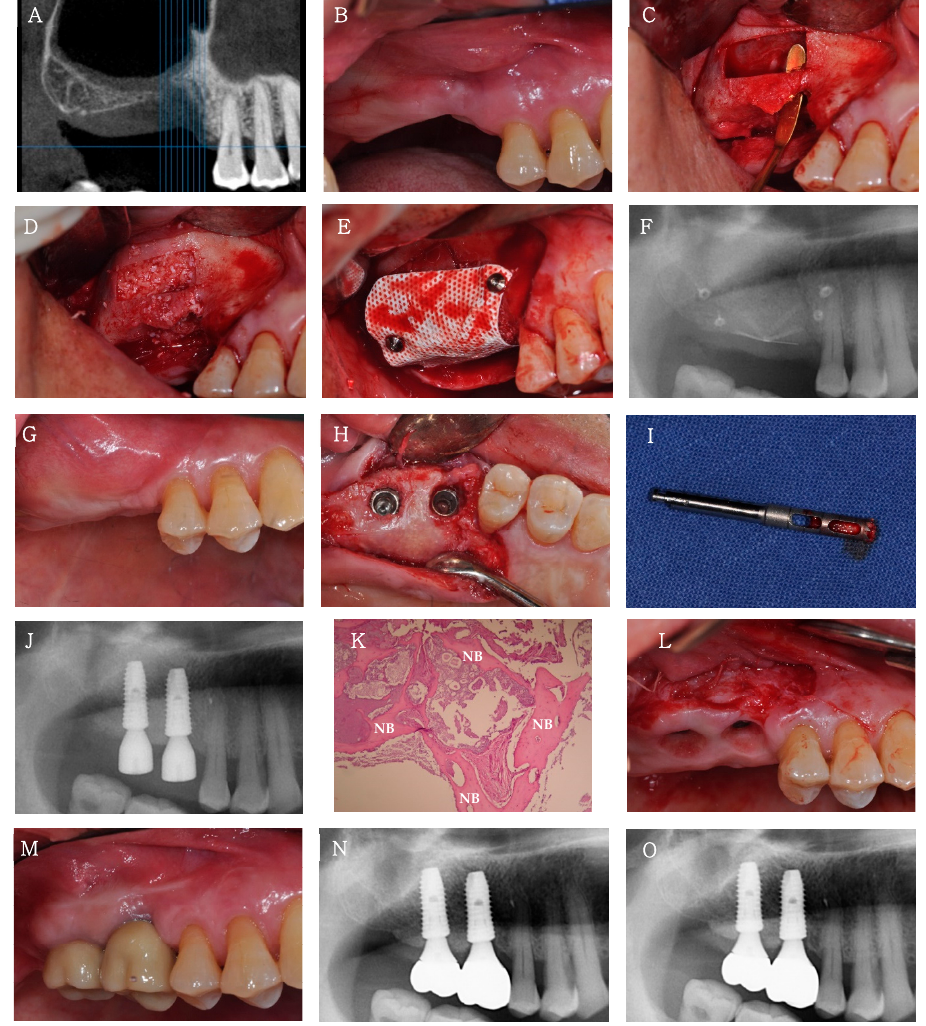
Figure 6. Clinical case 3. ( A , B ) Clinical and radiographic views before alveolar ridge and sinus augmentation in the 16 and 17 regions. ( C ) Buccal view after a piezoelectric bony window osteotomy and sinus membrane elevation. An oroantral communication is seen. ( D ) Sinus graft with Bontree ® . ( E ) Vertical ridge augmentation with Bontree ® and titanium-reinforced d-PTFE membrane after the replacement of the bony window. ( F ) Radiograph after sinus and ridge augmentation. ( G ) Buccal view before placement of implants 16 and 17 6 months after sinus and ridge augmentation. A coronally positioned mucogingival junction line is observed. ( H ) Occlusal view of implants 16 and 17 immediately after placement. ( I ) The core biopsy in the 16 region using a trephine bur. ( J ) Radiograph after the single-stage implant surgery. ( K ) Histological examination. New bone formation (NB) is observed with no inflammatory tissue (H&E-stained; original magnification × 100). ( L ) Buccal view after performing a modified periosteal fenestration 4 months after the single-stage implant surgery. ( M , N ) Clinical and radiographic views of the final prosthesis 6 months after the single-stage implant surgery. ( O ) Radiograph at 1 year after loading.